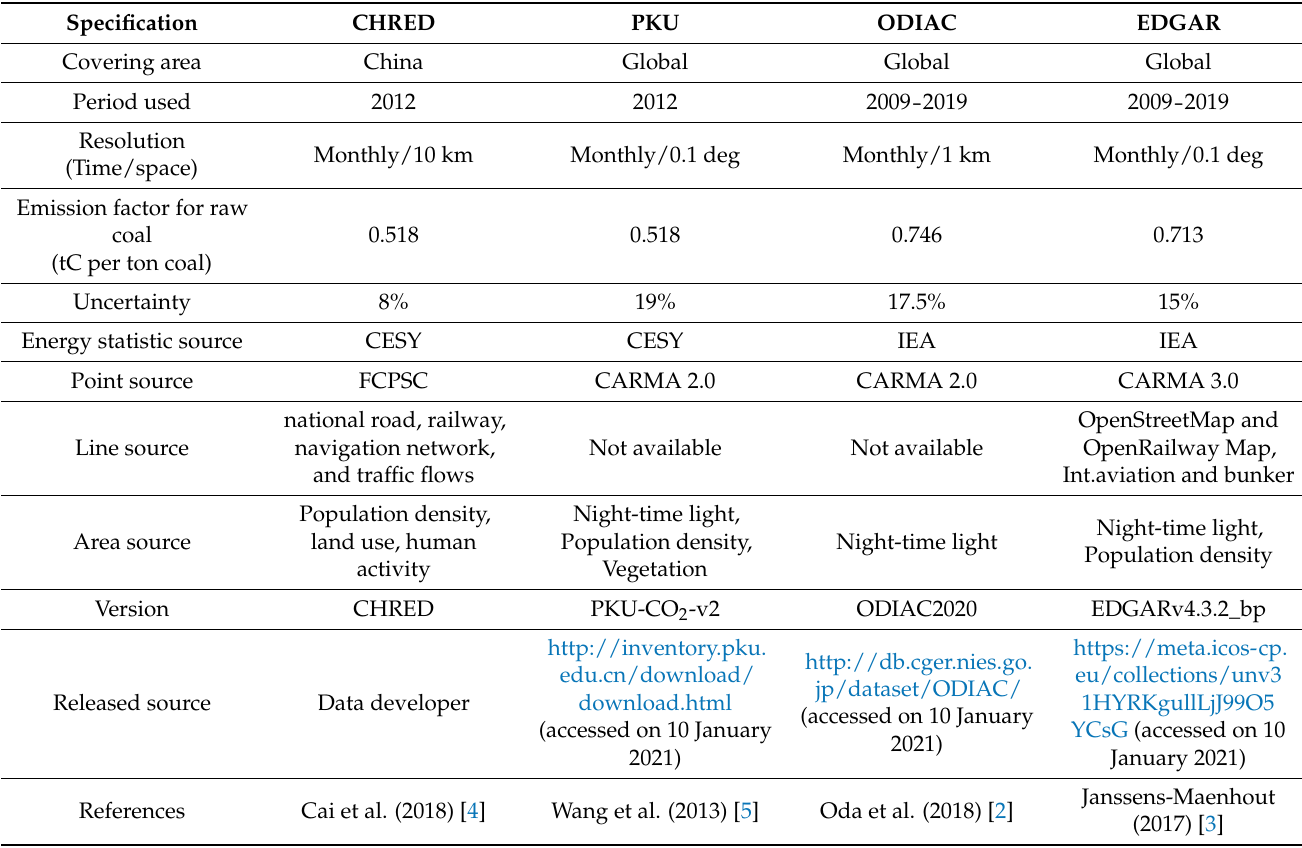
Table 1. Specifications of four selected anthropogenic CO 2 emission